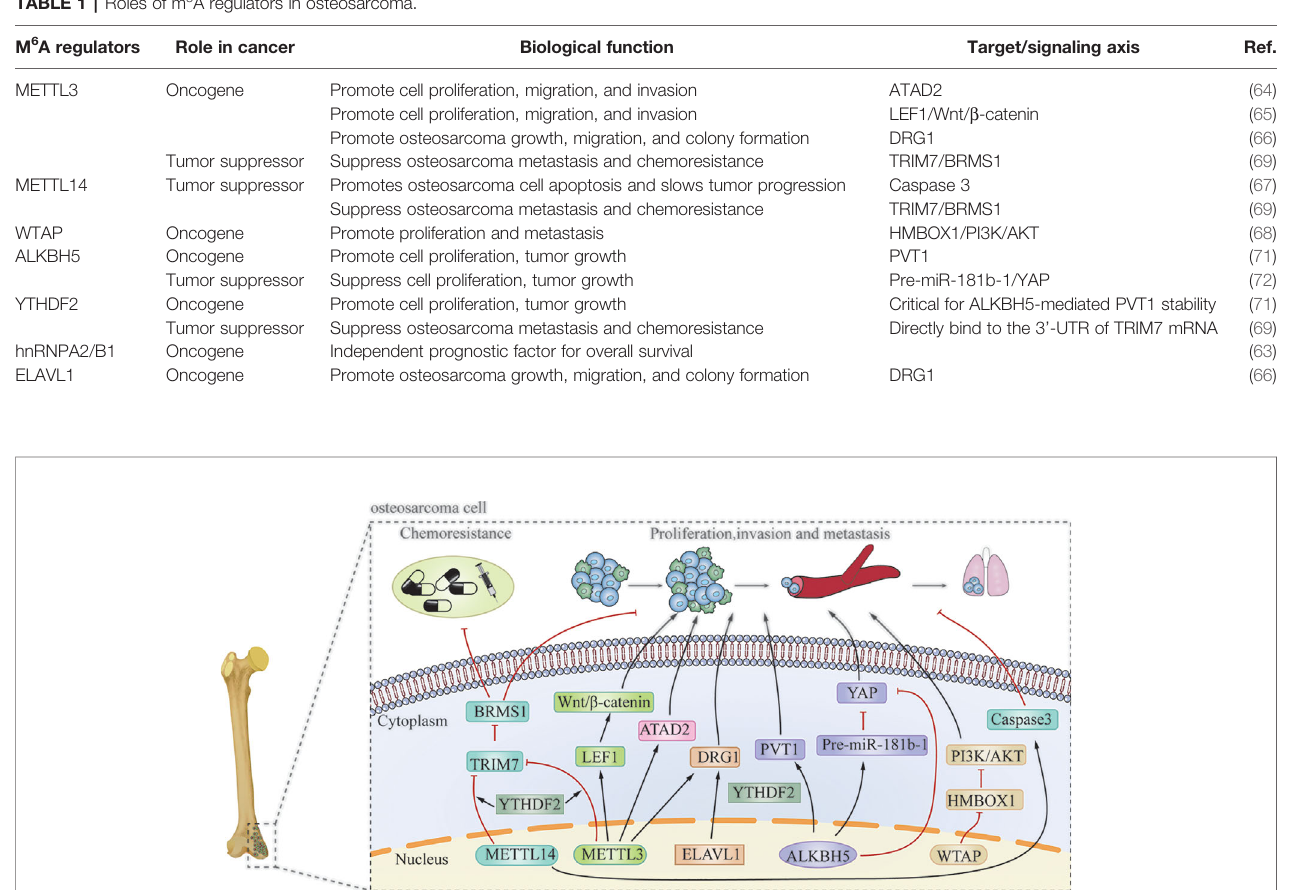
FIGURE 3 | The pathophysiological roles and molecular mechanism of m 6 A modi fi cation in osteosarcoma.